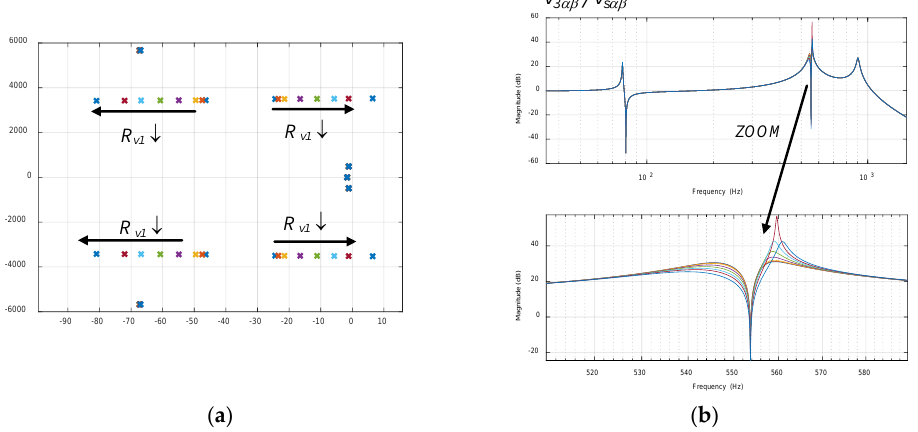
Figure 11. Dominant poles and Bode plots of the voltage at the Pcc with different active resistances ( R v 1 = 7.562 k Ω multiplied by factors of (1 0.75 0.5 0.25 0.15 0.1 0.075 0.05)) programmed at 550 Hz. ( a ) Dominant poles of the system, ( b ) Bode plot of v 3 αβ ( s )/ v s αβ ( s